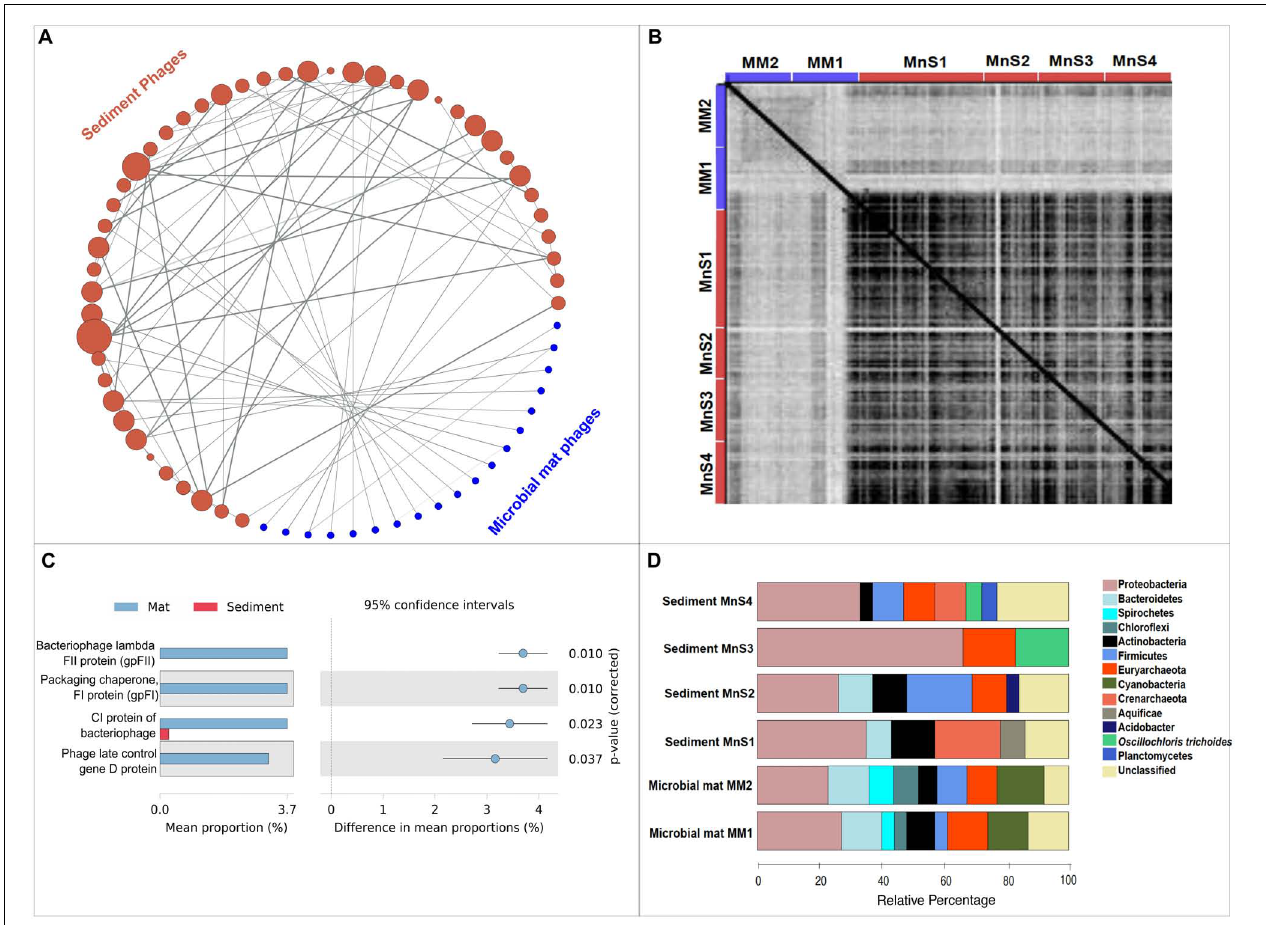
FIGURE 2 | (A) Network analysis performed between different phage genomes (reconstructed from both microbial mats and sediments based on tetranucleotide frequencies using average distance matrix. The networks were prepared in igraph. The nodes here stand for the different phage genomes; the node size is controlled by weight of the edges connecting the node. The edges of the network stand for correlation between the phage genomes based on abundance of tetranucleotide frequencies. The weights of the edges are based on the correlation values based on tetranucleotide frequencies between nodes. (B) Dot plot analysis of 65 tailed bacteriophage reconstructed across MM1, MM2, sediment samples (MnS1, MnS2, MnS3, and MnS4) based on whole-genome alignment score generated by Kalign. The dot plots were produced in Gepard at a word size setting of 10. (C) Differentially abundant ( p < 0.05, Welch’s two-group t -test) functional gene orthologs between phage genomes from sediment and microbial mats, and (D) phylum level assignment of CRISPR arrays across Manikaran metagenomes, i.e., microbial mat (MM1 and MM2) and sediments (MnS1, MnS2, MnS3,